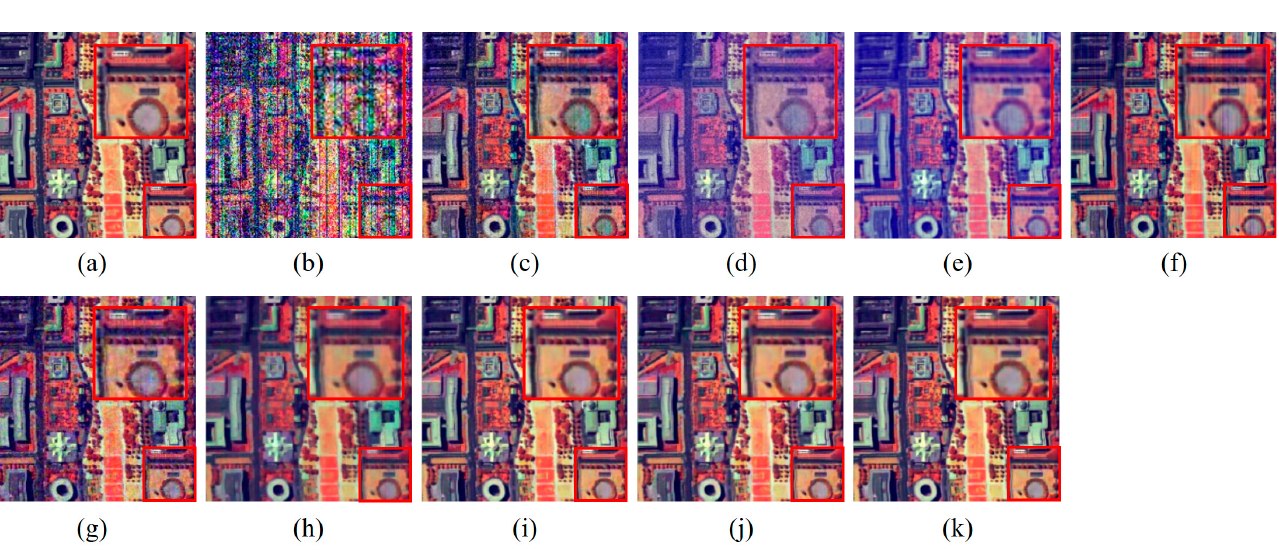
Figure 6. False color images synthesized with band 50, 70 and 110 of the denoised Washington DC data in mixture noise case. ( a ) Clean; ( b ) noisy; ( c ) LRMR; ( d ) NAILRMA; ( e ) NGmeet; ( f ) L1HyMixDe; ( g ) E3DTV; ( h ) LRTDTV; ( i ) HSI-DeNet; ( j ) HSID-CNN; ( k ) ours.